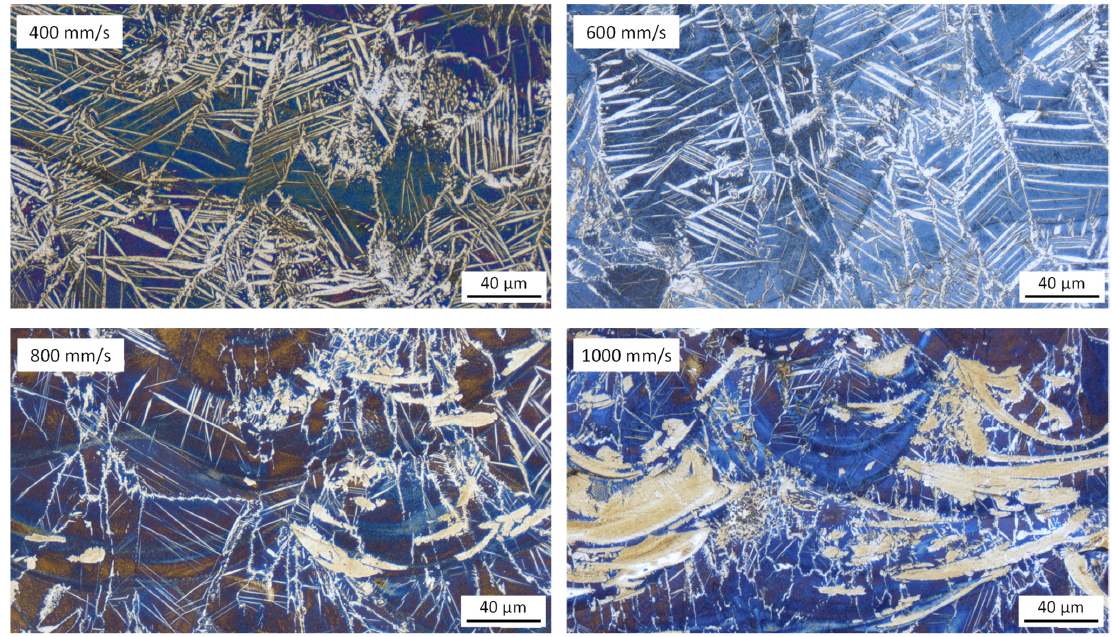
Figure 13. Influence of laser energy input on the microstructure of Mixture 50 ‐ 50 (laser power 250 W, laser scan speed 400–1000 mm/s), examined by using light optical microscopy. Building direction is upward for all images.